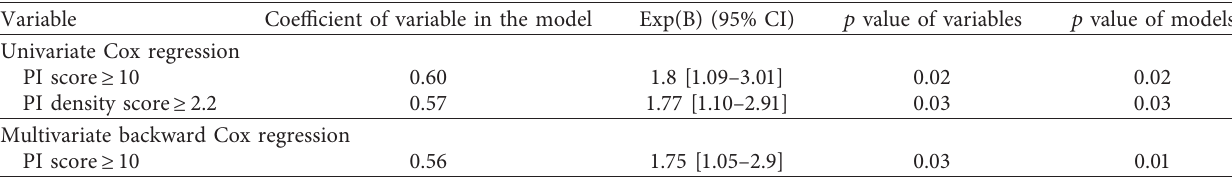
Figure 4: Kaplan–Meier survival curve. Estimated survival rate in (a) all deceased patients and comparisons based on (b) PI score and (c) PI density score. Table 3: Univariate and multivariate Cox